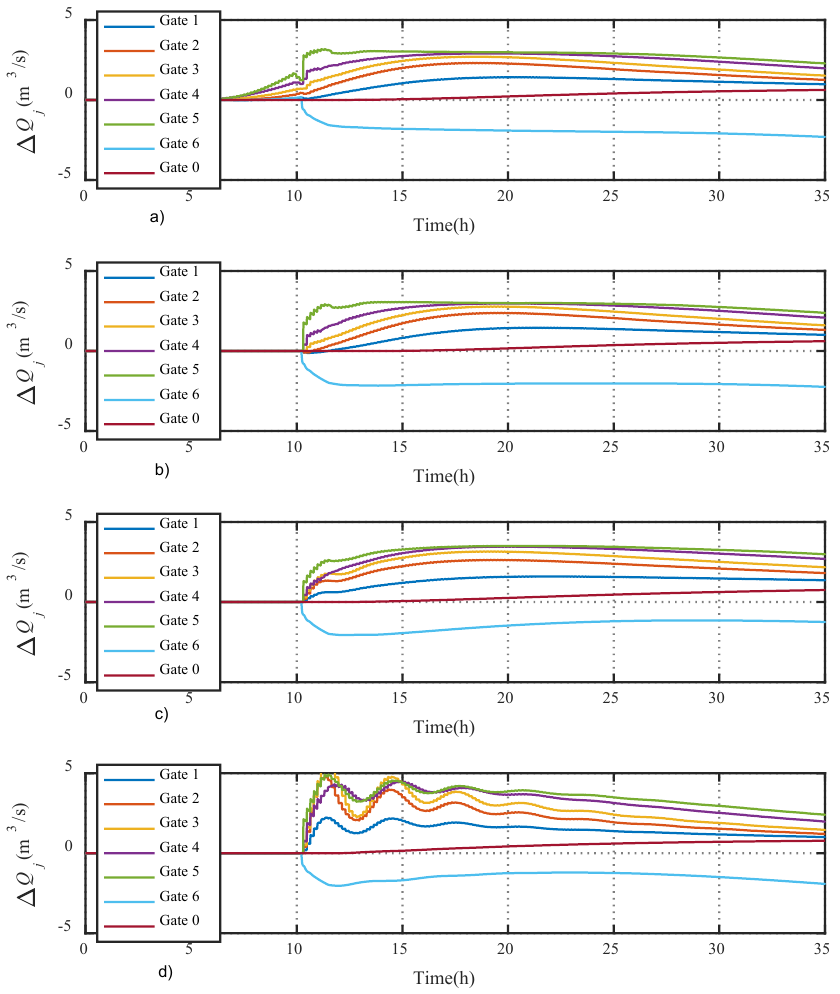
Figure 3. The simulation flow change result for scenario No. 1 with MPC-I control ( a ), MPC-I control ( b ), LQR I ( c ), and LQR II ( d ).